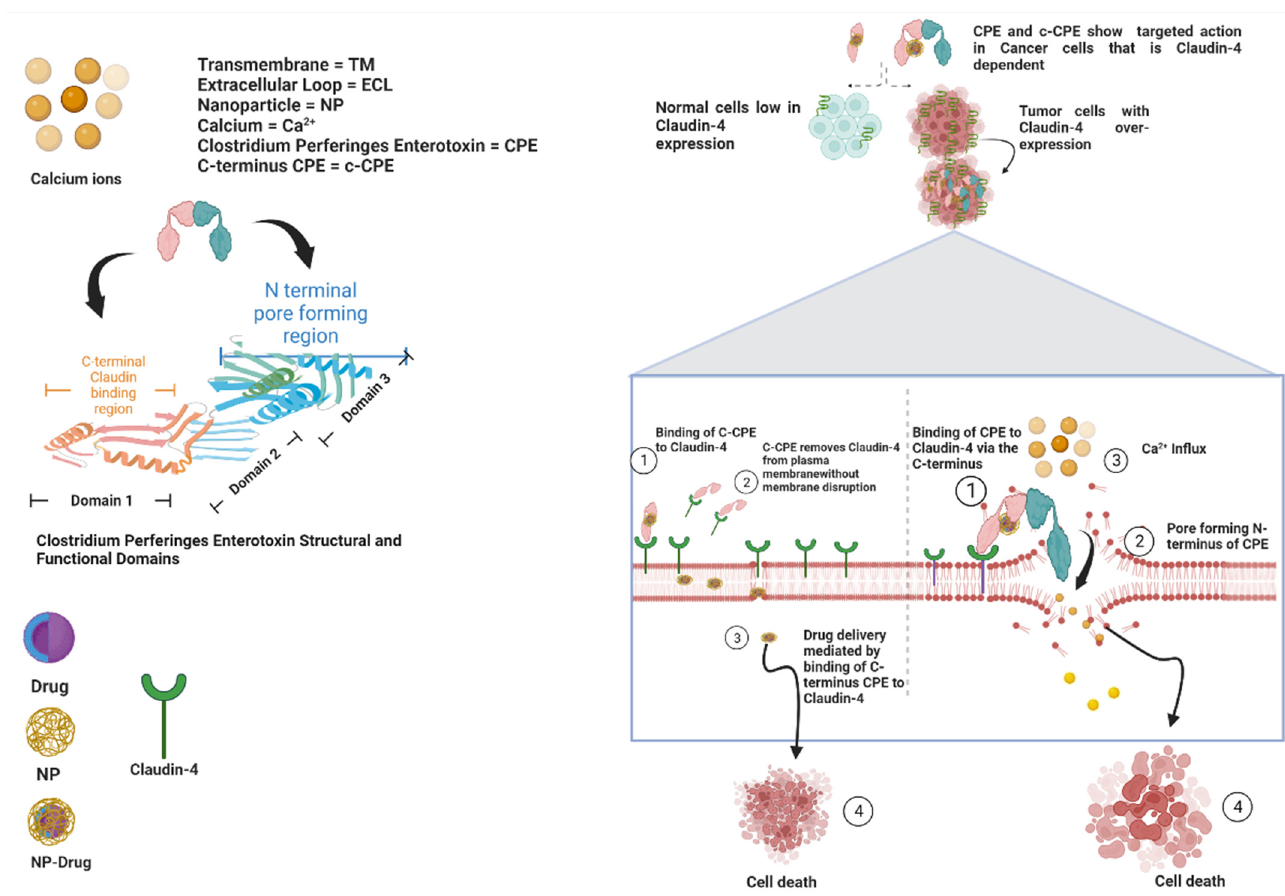
Figure 4. Diagrammatic representation of the mechanisms of CPE and c-CPE interaction with Claudin-4 and structural and functional domains of both CPE and Claudin-4.